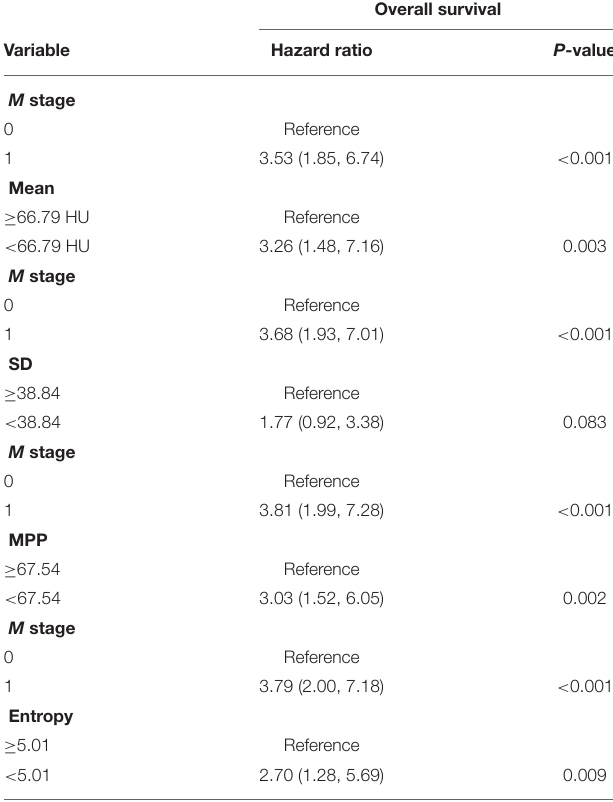
TABLE 4 | Multivariate Cox proportional hazard analysis of clinicopathologic variables and CT texture features without image filtration associated with worse overall Overall survival